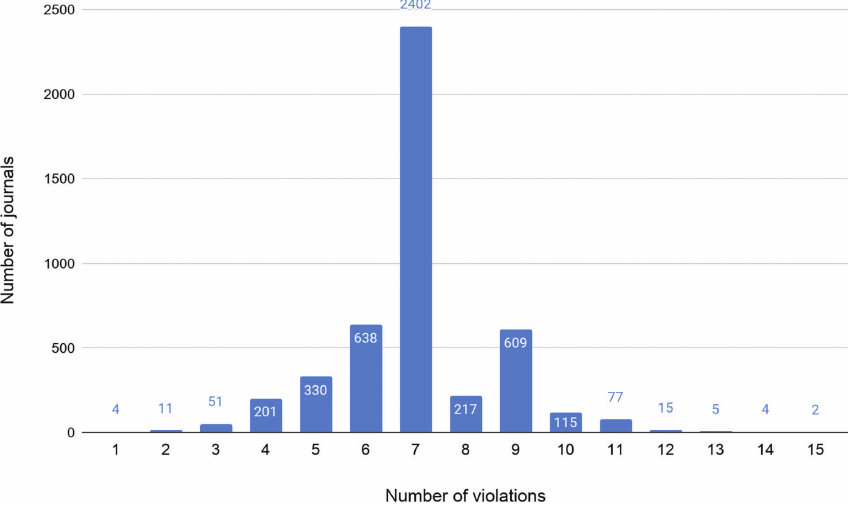
Fig. 3: Number of journals included in Cabell’s blacklist as per number of violations (as per Cabell’s